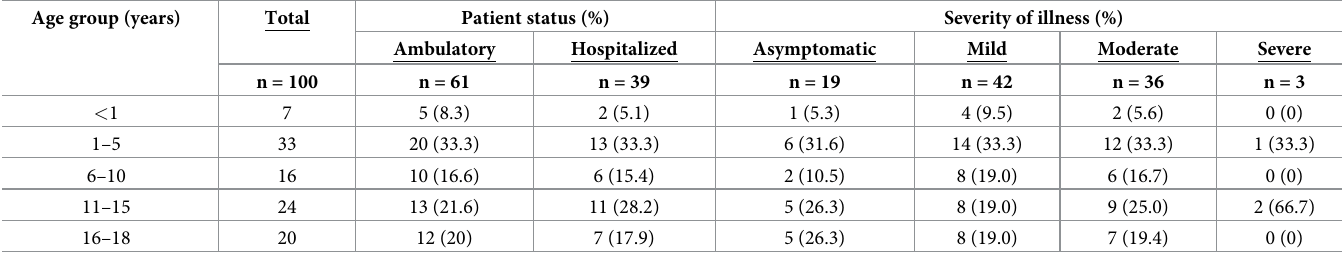
Table 2. Distribution of patient status and severity of illness in Mexican children and adolescents with